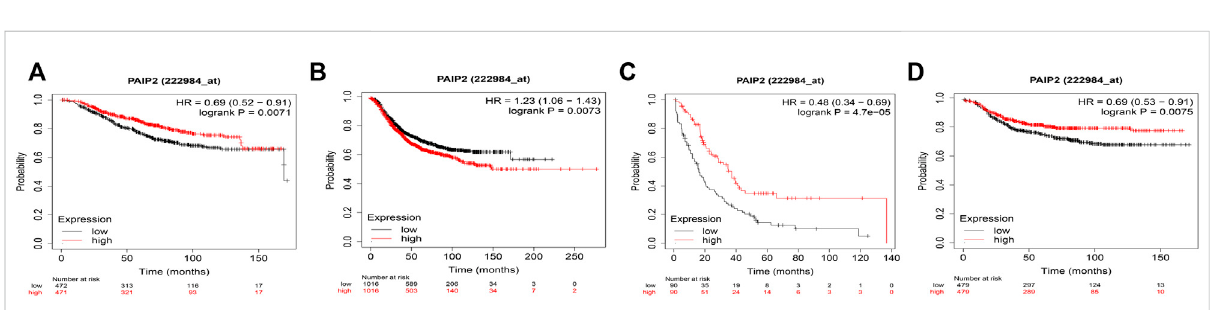
Correlation between PAIP2 and prognosis of breast cancer patients. (A) : The high expression of PAIP2 is associated with better OS in breast cancer patients. (B) : High expression of PAIP2 is associated with poor RFS in patients with breast cancer. (C) : The high expression of PAIP2 was associated with better PPS in breast cancer patients. (D) : The high expression of PAIP2 is associated with better DMFS in breast cancer